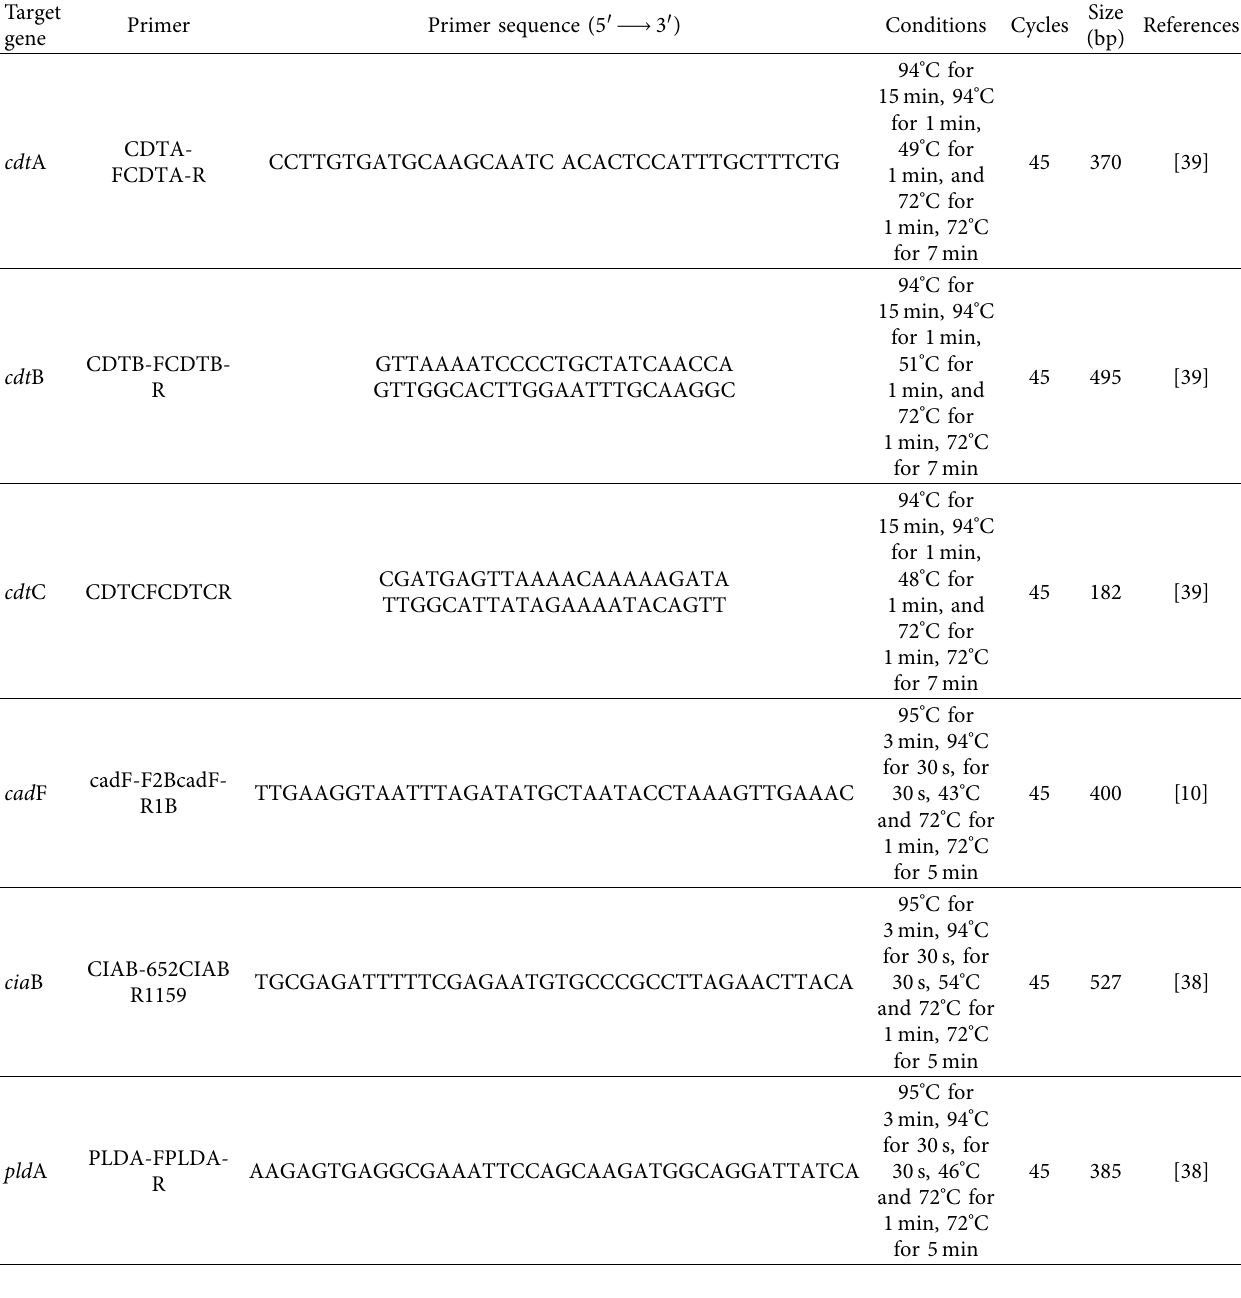
Table 2: Primer sequences of virulence genes and PCR conditions used in this